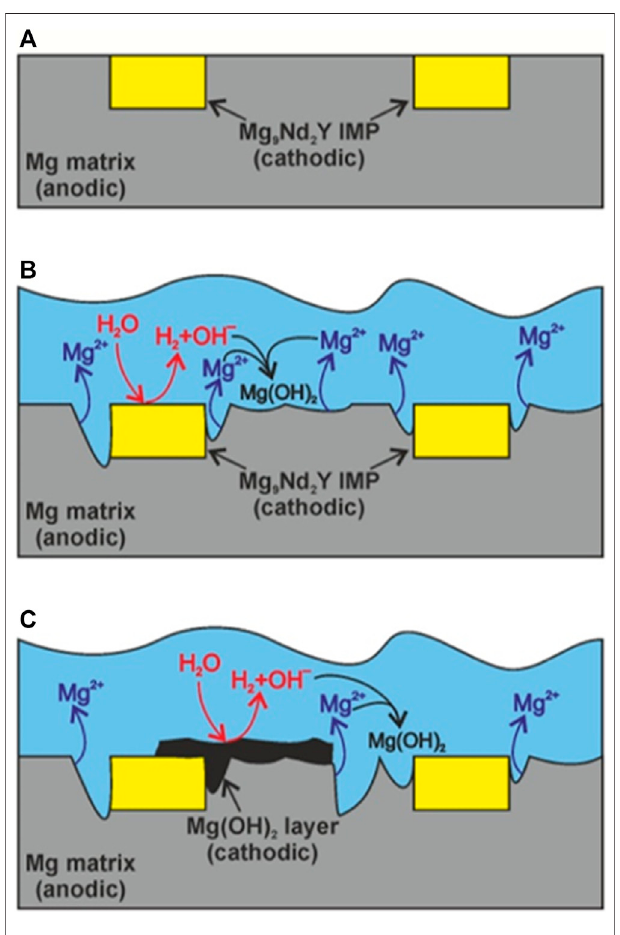
FIGURE 2 | Possible mechanism of corrosion for WE series magnesium alloys (A) , involving the formation ofaMg(OH) 2 layer onthe surface ofthealloy (B) , with localized microgalvanic corrosion at preferential sites (C) . Figure reproducedfrom(Kharitonovetal.,2021)underthetermsoftheCreative Commons CC-BY 4.0